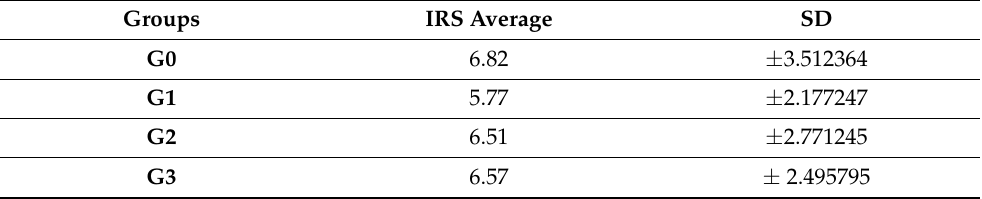
Table 10. Evaluation of vaspin expression in the control group and the study group according to the histopathological differentiation of the tumor: IRS, Immunoreactive scale; SD, standard